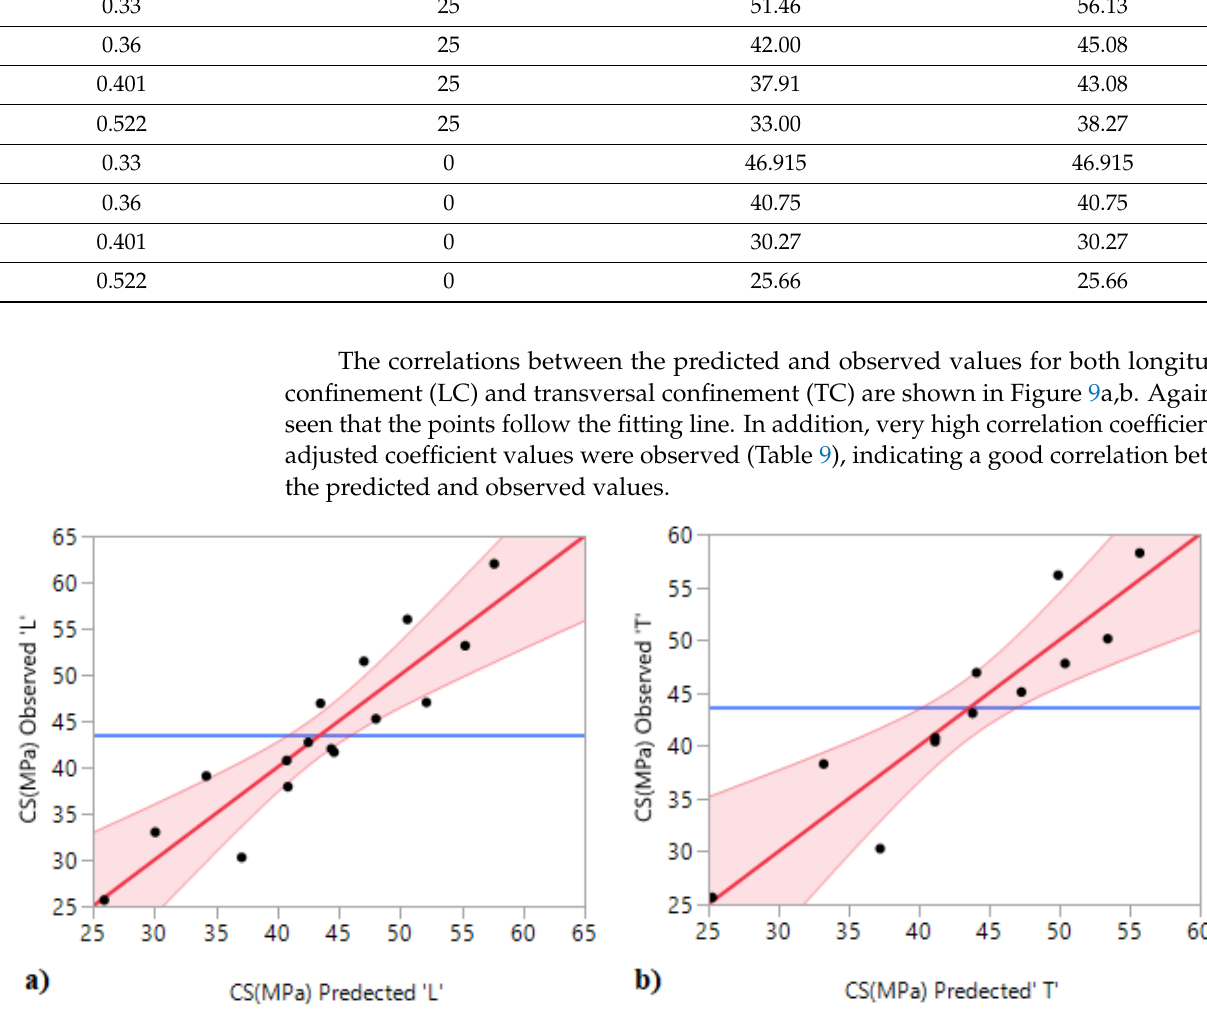
Figure 9. Correlation between experimental and predicted values: ( a ) longitudinal confinement (LC); and ( b ) transversal confinement (TC).